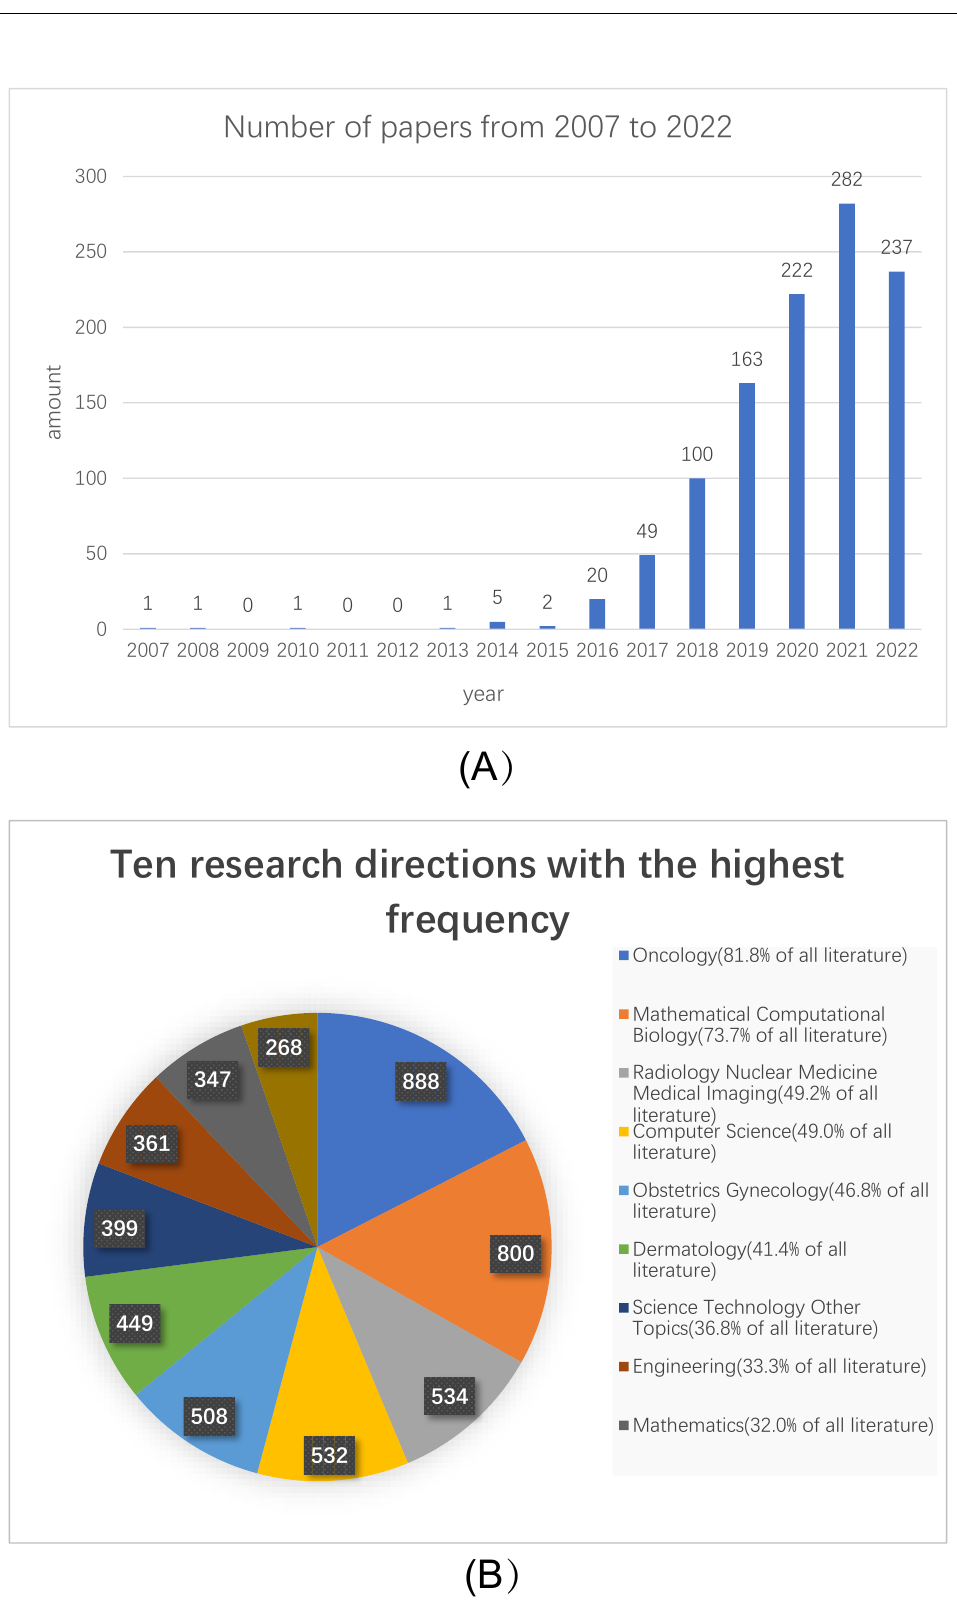
Figure 1. Publication of articles on deep learning of pathological images of breast cancer. ( A ) Year of publication of the article on deep learning in breast cancer pathological images. ( B ) Summary of the themes of review-type articles in articles on the application of deep learning to breast cancer pathological